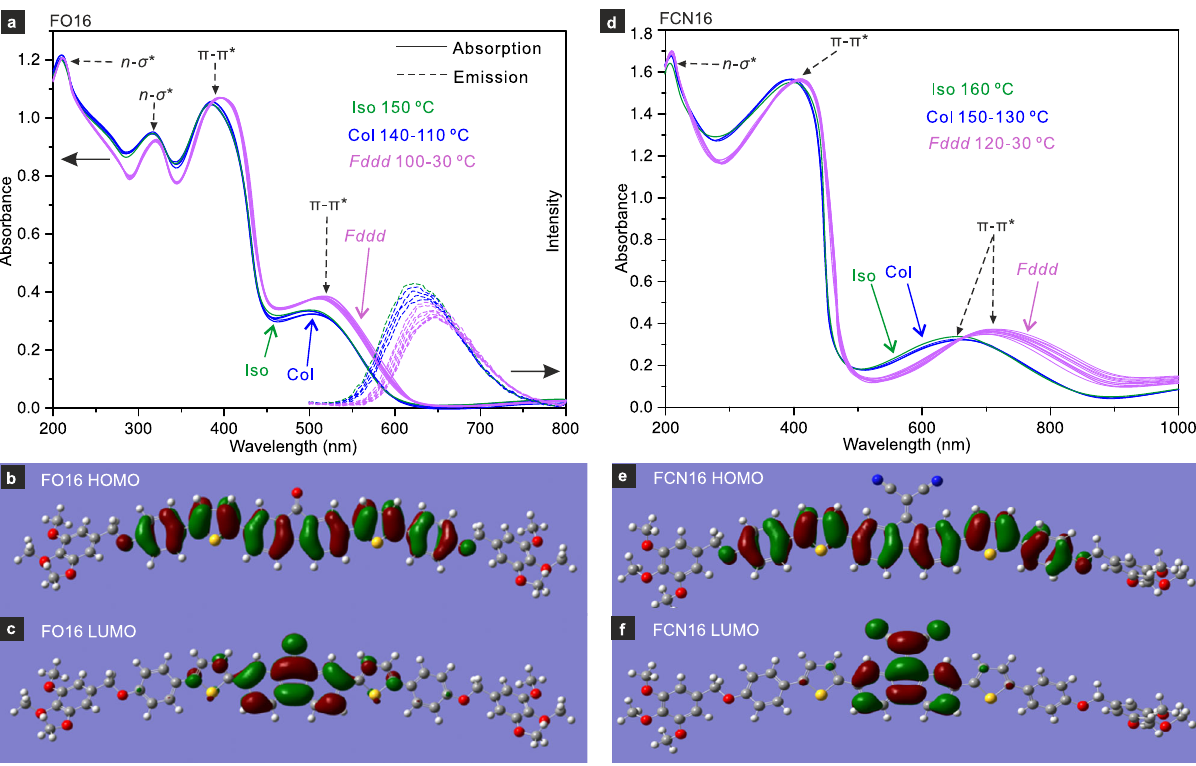
Fig. 8 UV – vis – fl uorescence spectra and HOMO-LUMO orbitals. a UV – vis and fl uorescence emission spectra and b HOMO and c LUMO orbital isosurfaces of FO16. d UV – vis, e HOMO, and f LUMO orbitals of FCN16. Spectra are recorded during cooling from isotropic phase. FO16 emission is excited at 420 nm. HOMO and LUMO energies and bandgaps calculated by DFT (B3LYP/6-31G) are E HOMO = − 5.02 eV, E LUMO = − 2.25eV, Δ E = 2.77 eV for FO16 and E HOMO = − 5.11 eV, E LUMO = − 3.12 eV, Δ E = 1.99 eV for FCN16. The bandgaps measured from vis spectra by the Tauc plot method 49 are 2.15 eV (Col) and 2.10 eV ( Fddd ) for FO16, and 1.52 eV (Col), and 1.35 eV ( Fddd ) for FCN16 (see Supplementary Table 12). FCN16 is expected to emit in near IR (not